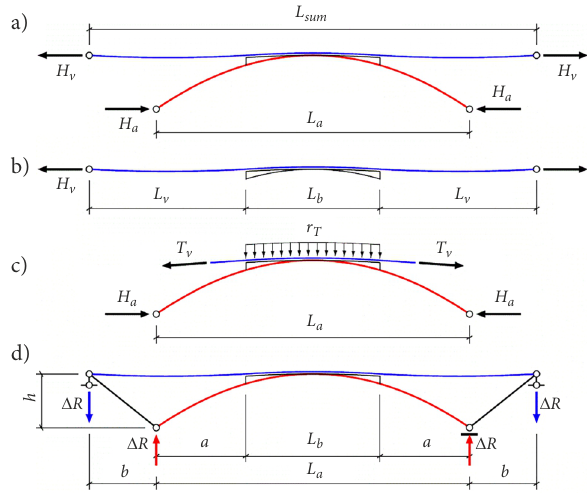
Figure 1. A component scheme for suspension through arch bridge